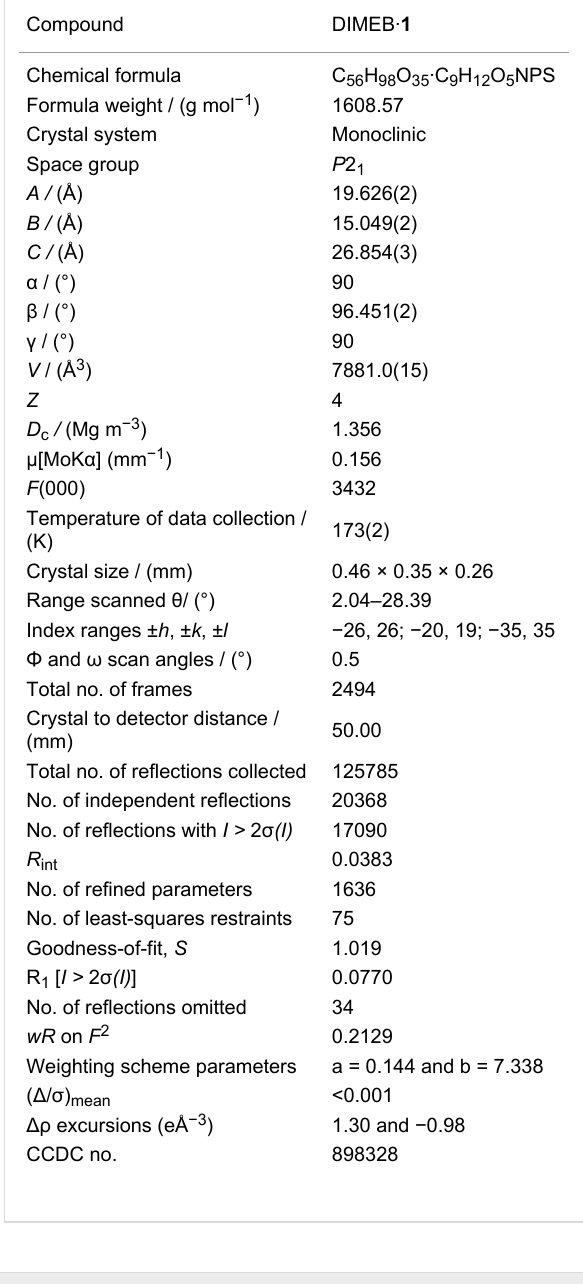
Table 2: Crystal data and data-collection